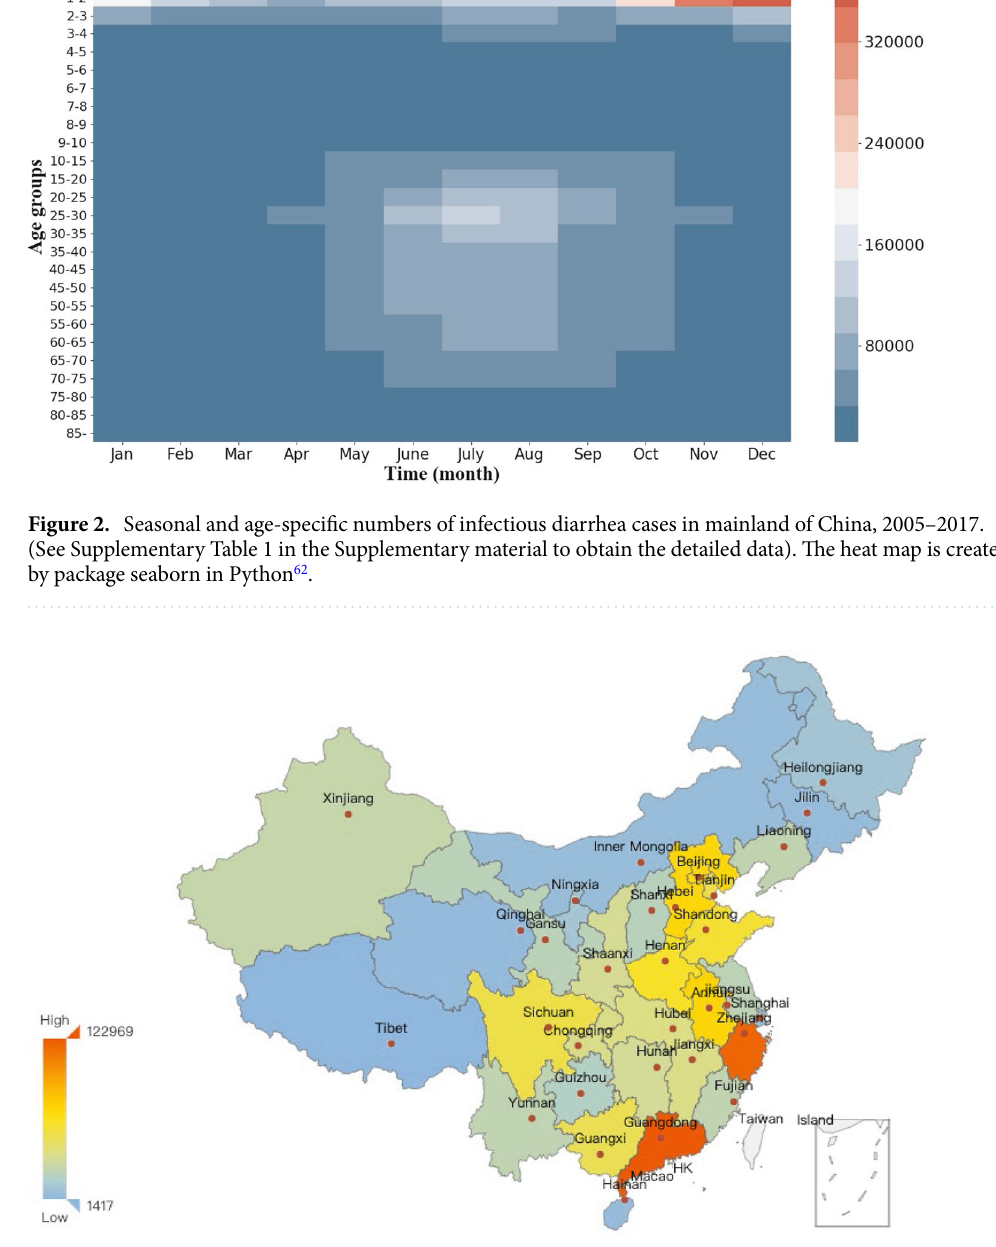
Figure 3. The yearly averaged numbers of infectious diarrhea cases in each province of mainland of China during 2005–2017. The map is generated by an open source package called pyechart in Python 63